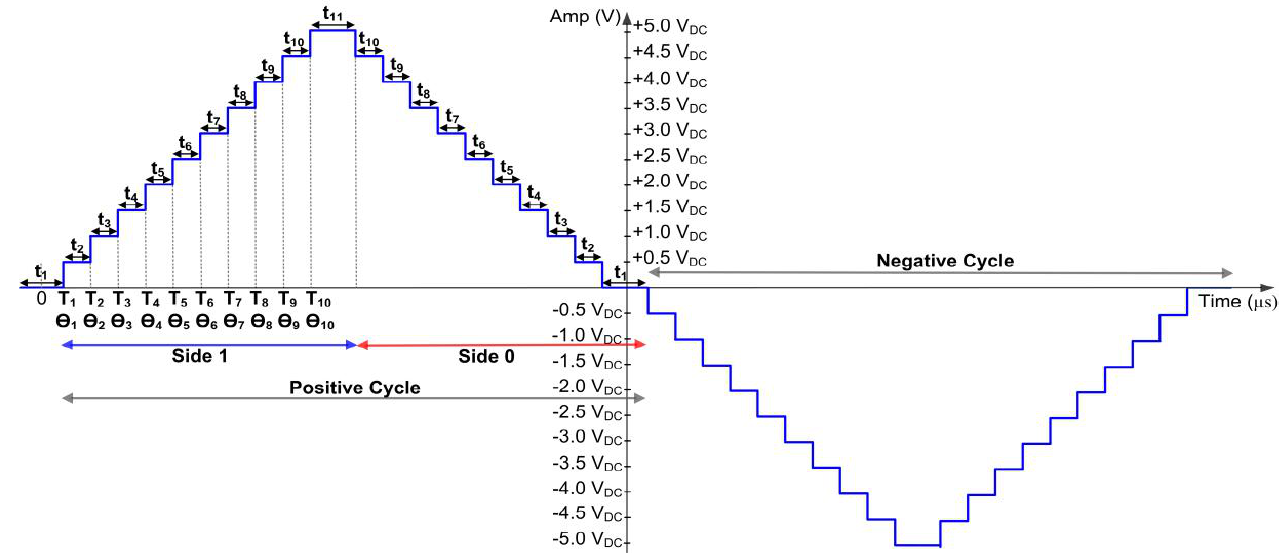
Figure 5. Location of switching time (T 1 –T 10 ), switching angles ( θ 1 – θ 10 ), and step-time duration (t 1 –t 11 ) in the stepped sine-wave output